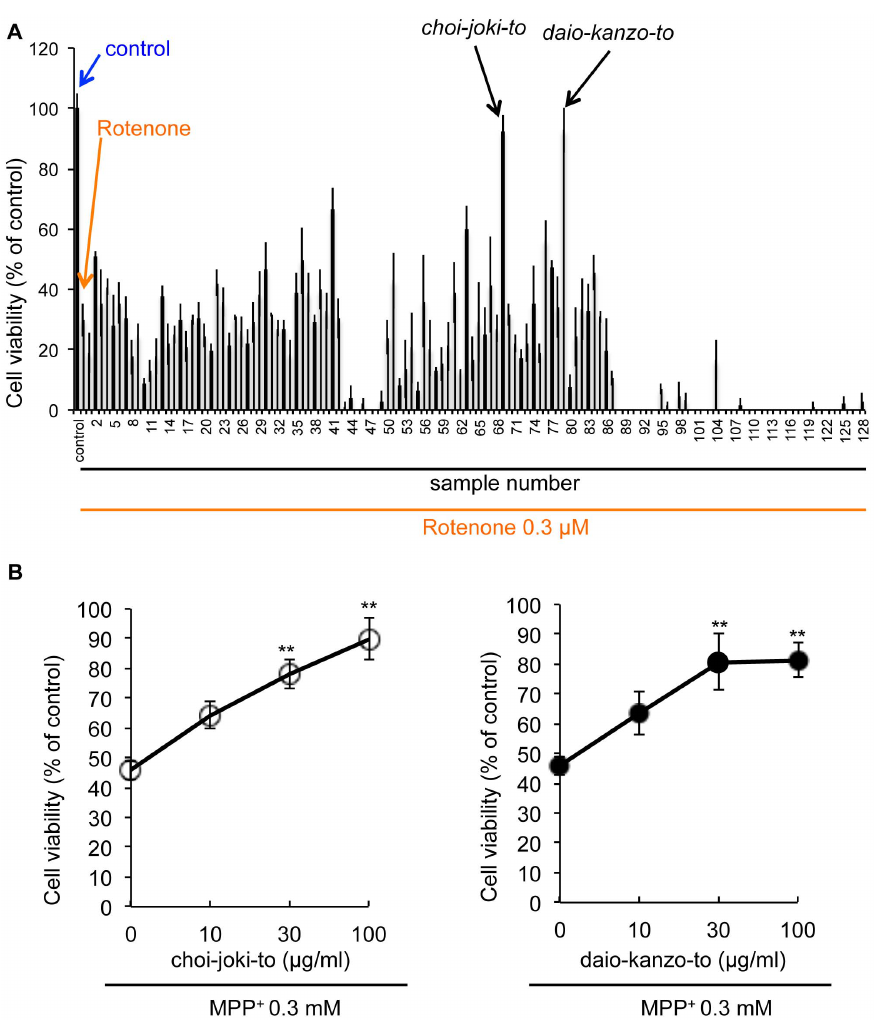
Figure 1. Two herbal medicines, daio-kanzo-to and choi-joki-to , identified as neuroprotective agents in the course of screening. ( A ) NGF-differentiated PC12D cells were treated with 0.3 m M rotenone and herbal medicine extract for 48 h. Cell viability was evaluated by trypan blue dye exclusion assay. ( B ) NGF-differentiated PC12D cells were treated with various concentrations of choi-joki-to or daio-kanzo-to in the presence of 0.3 mM MPP + for 48 h. Cell viability was evaluated by trypan blue dye exclusion assay. Values are the means of triplicate samples; bars, s.d. ** p , 0.01 compared with MPP + group cells.